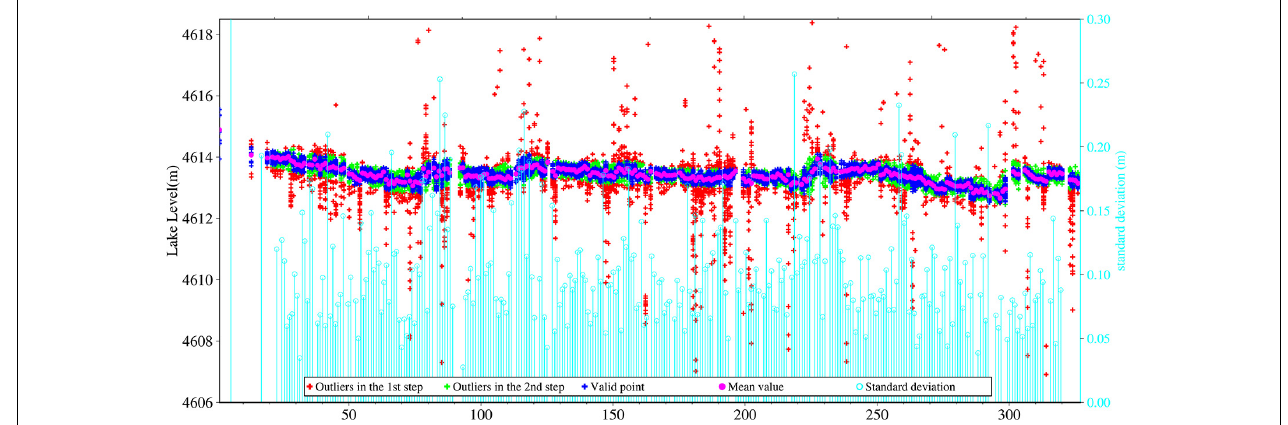
FIGURE 5 | Example of outlier detection in the case of Jason-2 observations over Zhari